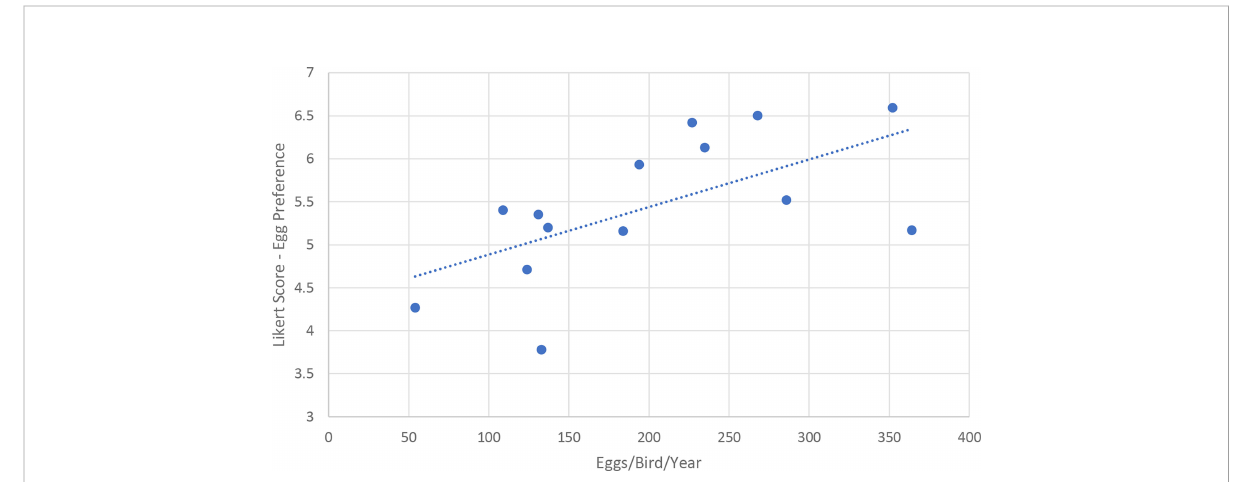
FIGURE 5 Scatter Plot modelling “ I would prefer to buy eggs from chickens that have not been kept in cages ” (Y) for all countries against “ Eggs produced per hen per year ” (R 2 =